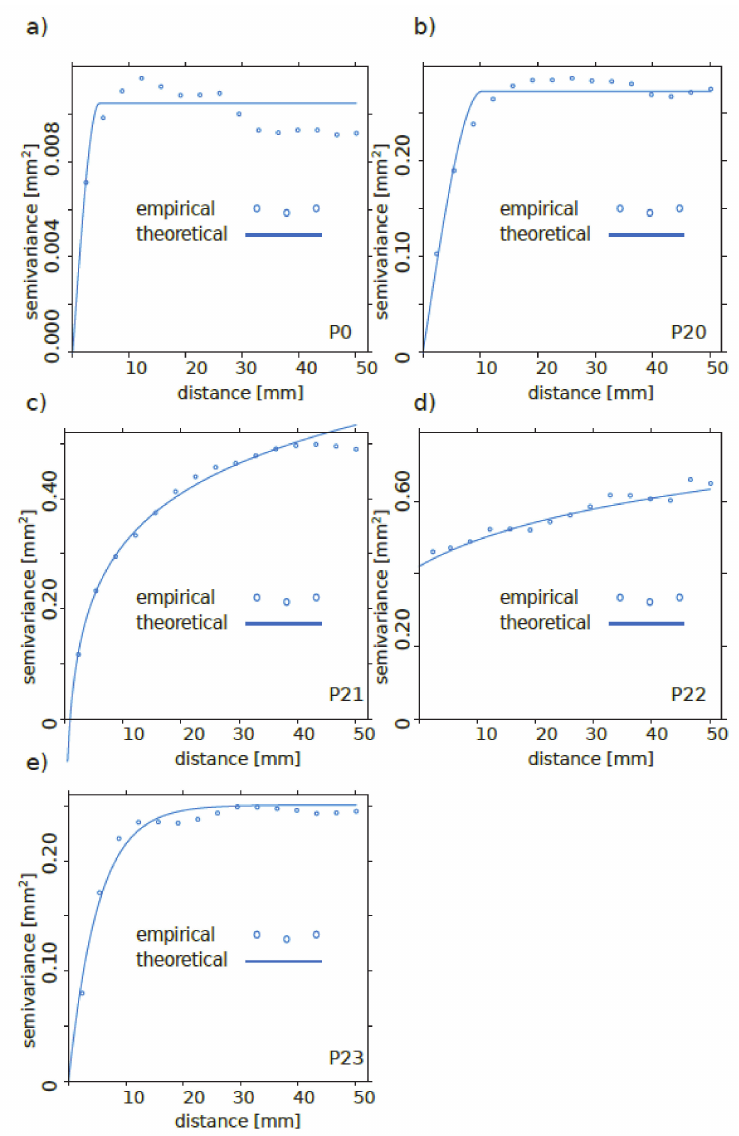
Figure 15. Empirical and theoretical semivariograms for samples: ( a ) P0, ( b ) P20, ( c ) P21, ( d ) P22, ( e )